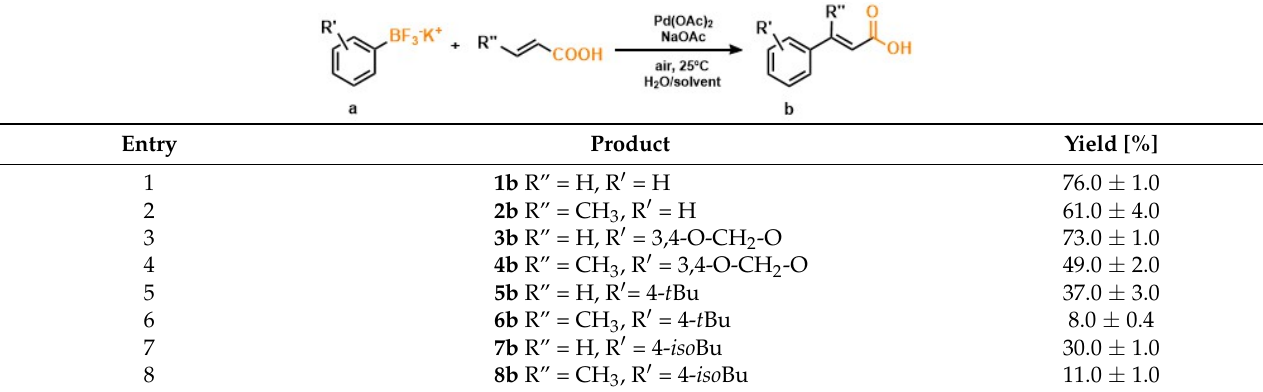
Table 1. Heck coupling efficiency in water with 10% DMSO.